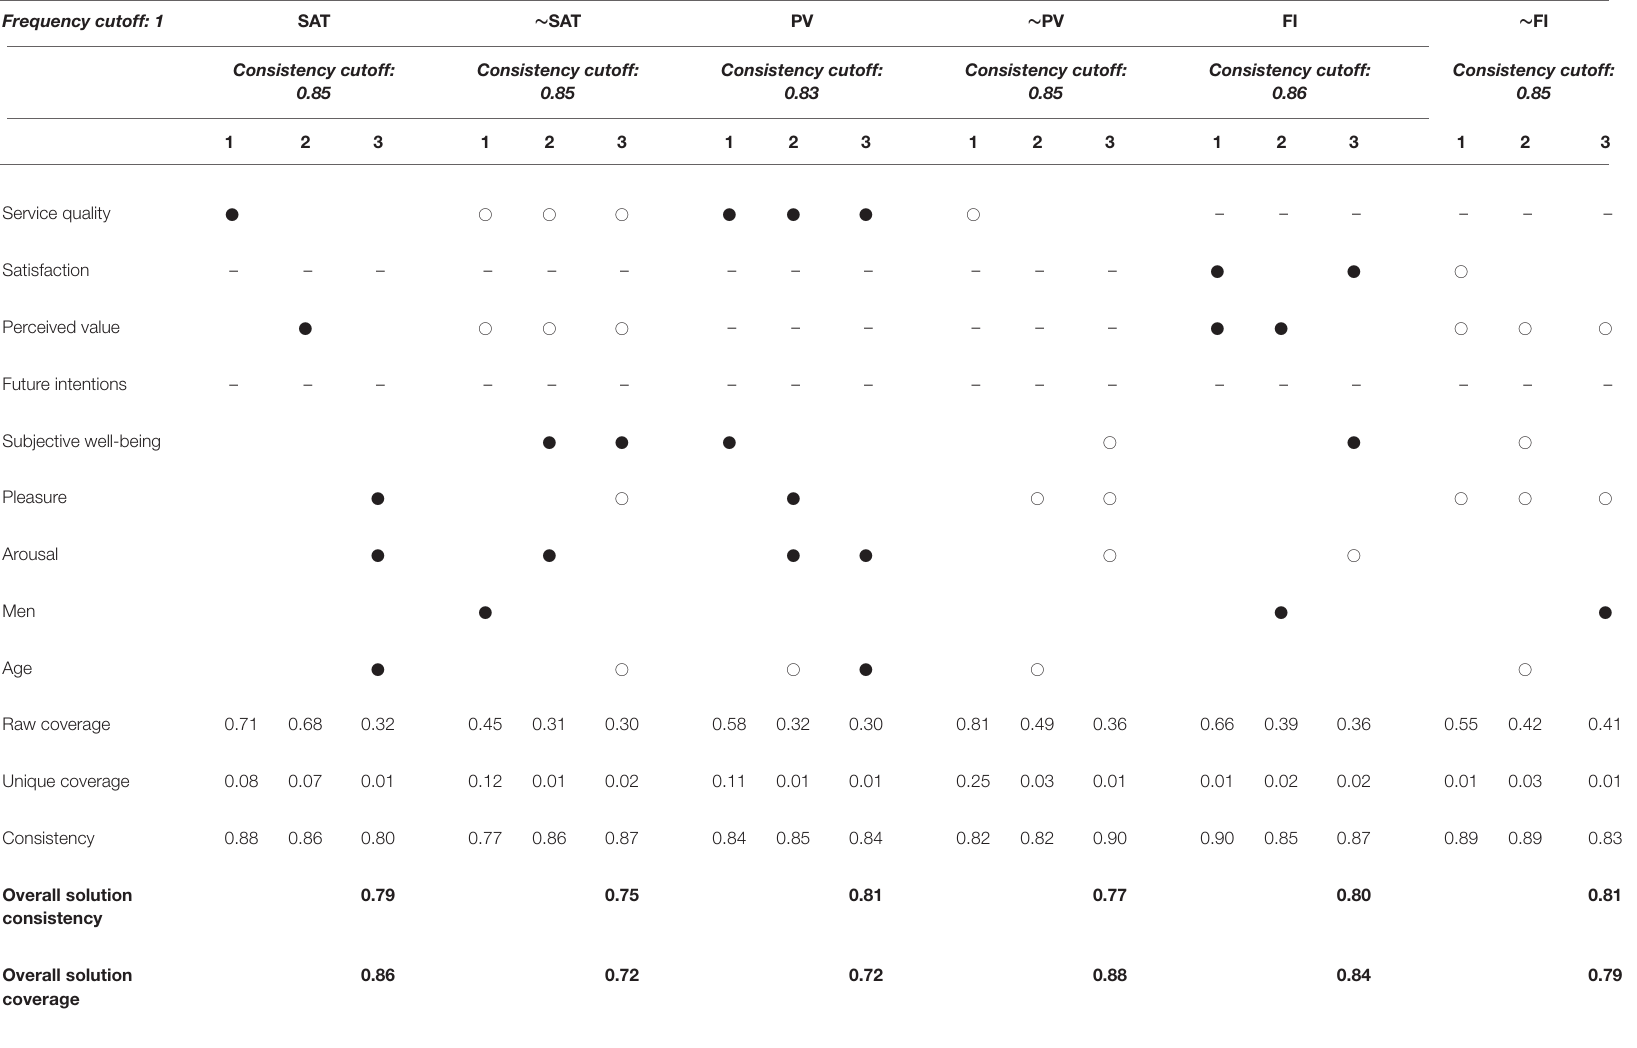
TABLE 4 | Three main conditions of sufficiency analysis for satisfaction, perceived value, and future intentions (intermediate solution). Frequency cutoff: 1 SAT ∼ SAT PV ∼ PV FI ∼ FI Consistency cutoff: 0.85